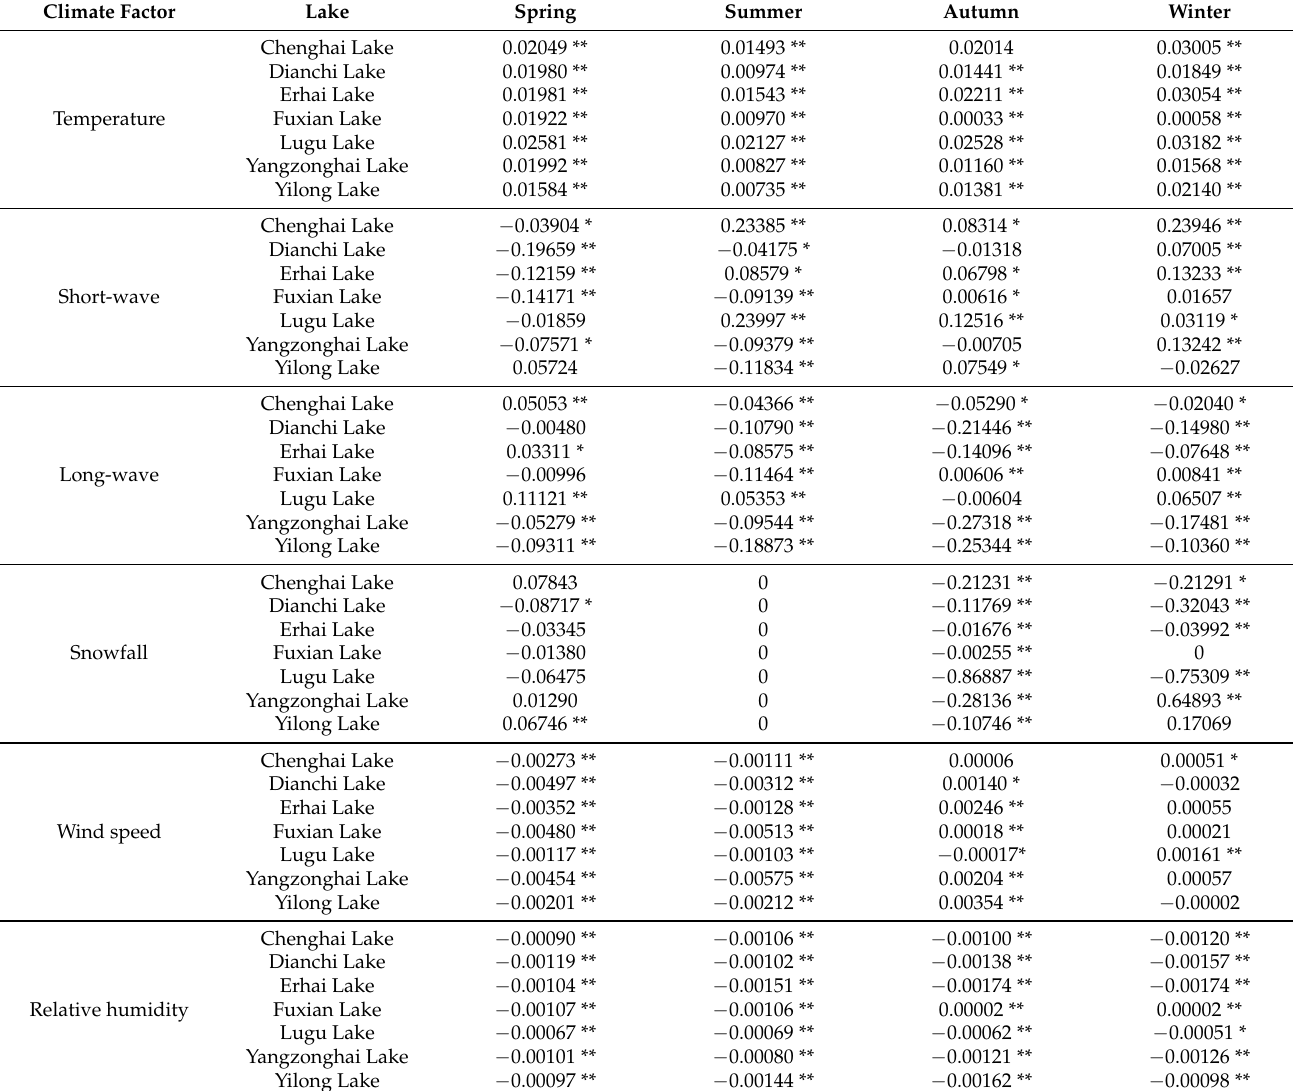
Table 3. Results of innovation trend analysis of seasonal climate factors in the Yunnan Plateau